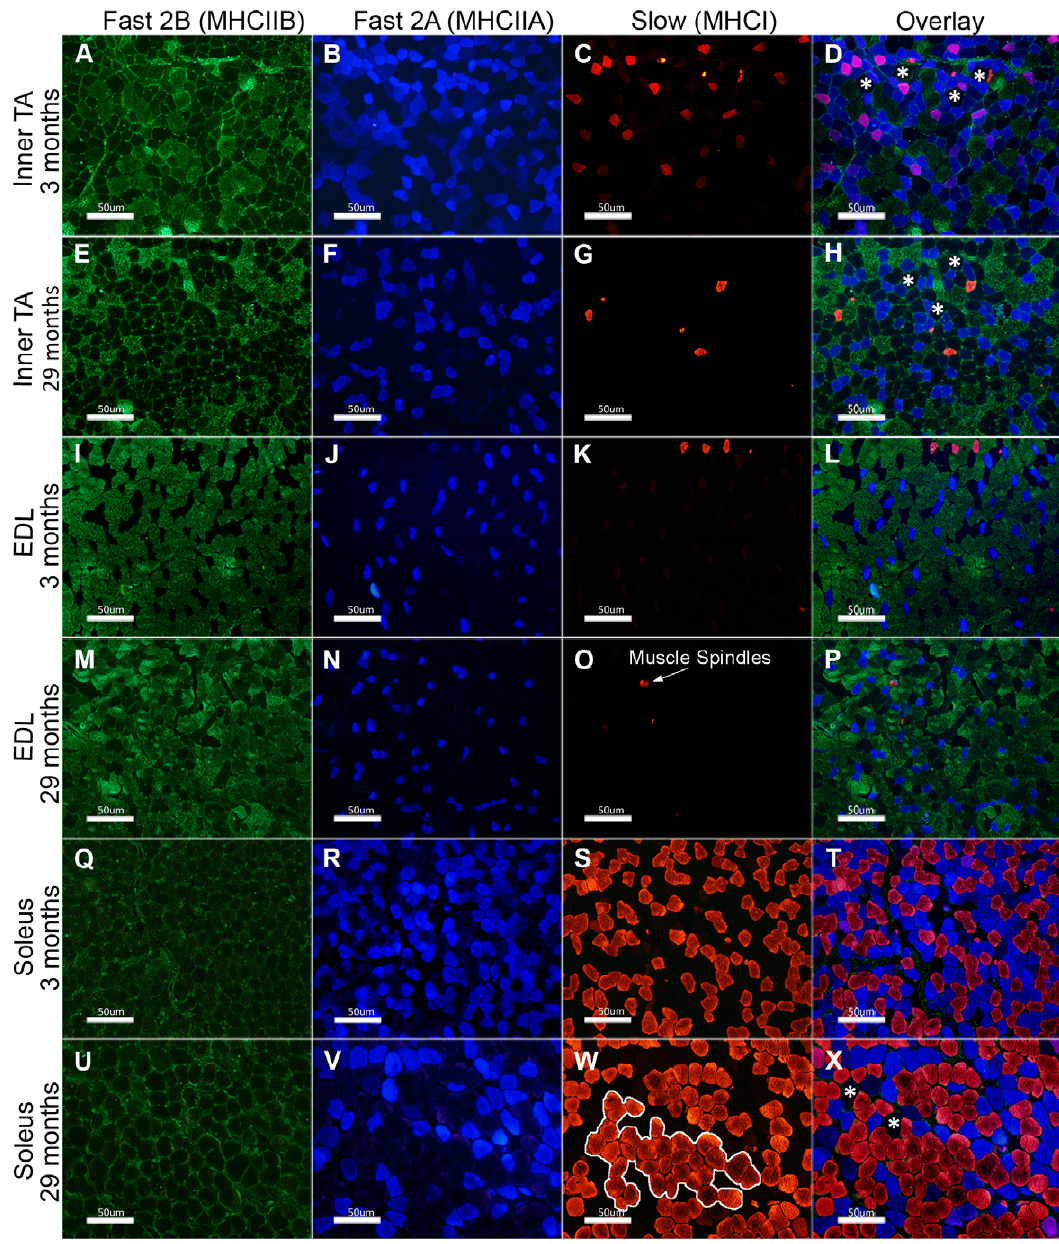
Figure 6. Fast 2B, Fast 2A and slow myofibres in the inner TA, EDL and soleus muscles. Antibodies for MHCIIB, MHCIIA and MHCI were used to detect three different types of myosin respectively: fast 2B (A,E,I,M,Q,U), fast 2A (B,F,J,N,R,V) and slow (C,G,K,O,S,W). The overlay of these is shown in D,H,L,P,T and X. Myofibres not detected with either of these antibodies were presumed to be fast 2 6 (MHCIIX) (a few are indicated by asterisks * in D, H, X). Along with the slow type myofibres, antibody for MHCI also stains muscle spindles (arrow in O). Grouping of slow type 1 myofibres was seen in 29 month soleus muscles (outlined in W). Scale bars are 50 m m.